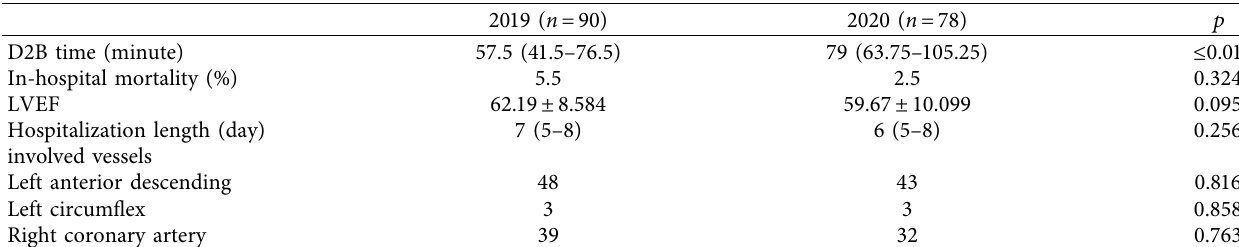
Table 3: D2B time and prognosis of STEMI patients receiving